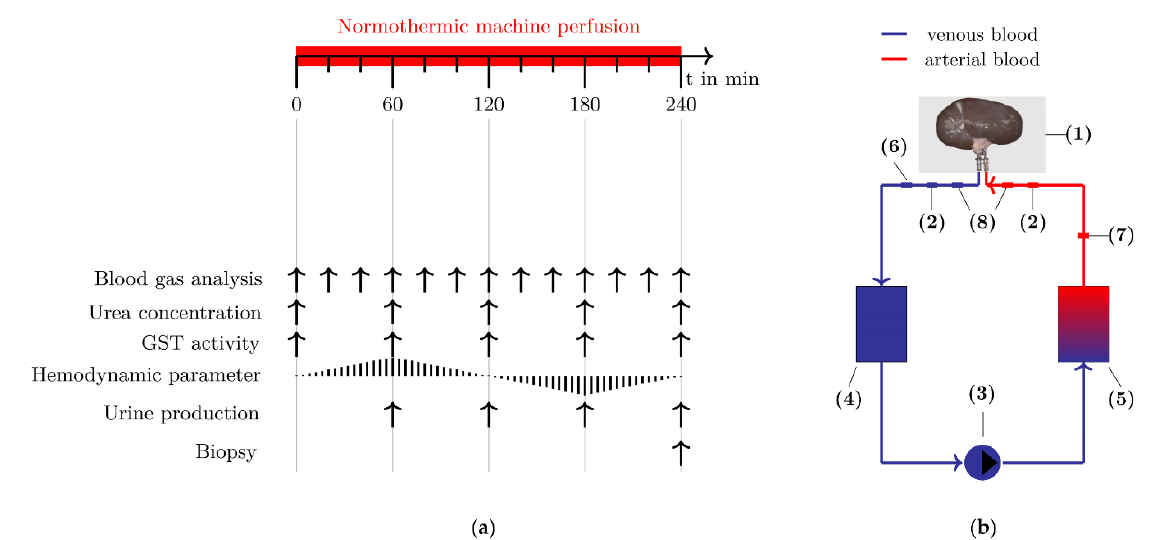
Figure 1. Normothermic machine perfusion (NMP) setup. ( a ) Before connecting the kidneys to the perfusion system, baseline blood samples were taken at t = 0 min. Subsequently, the blood, urine and tissue markers were measured at regular intervals. ( b ) The NMP system consists of the following components: (1) organ storage tray, (2) blood collection sites, (3) roller pump, (4) reservoir, (5) oxygenator, (6) temperature sensor, (7) pressure sensor, and (8) tube clamp.